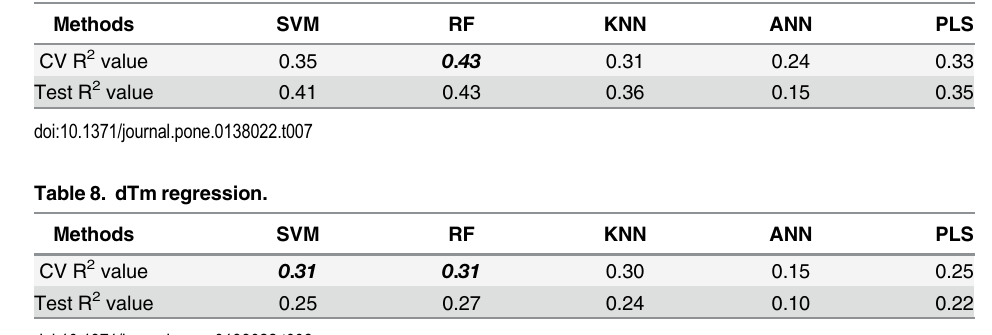
Table 7. ddG regression.